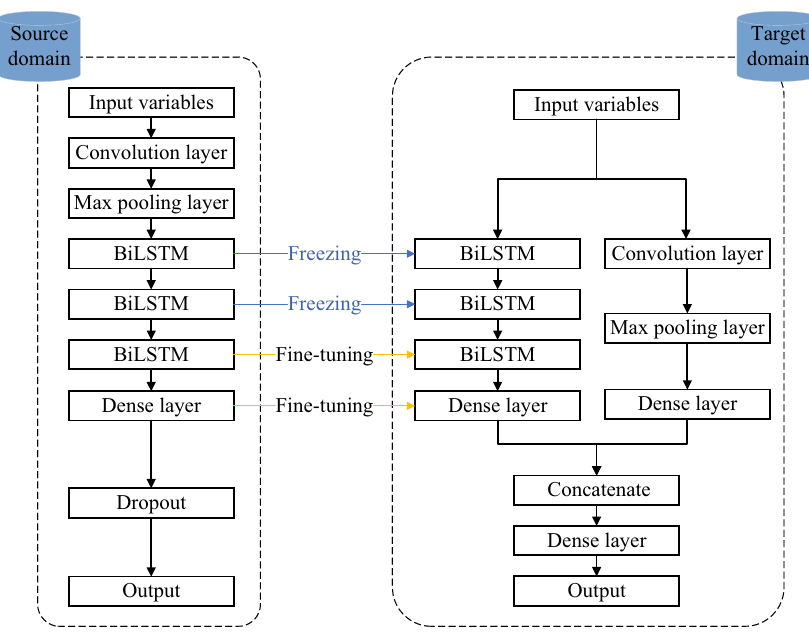
Figure 2. The framework of the proposed